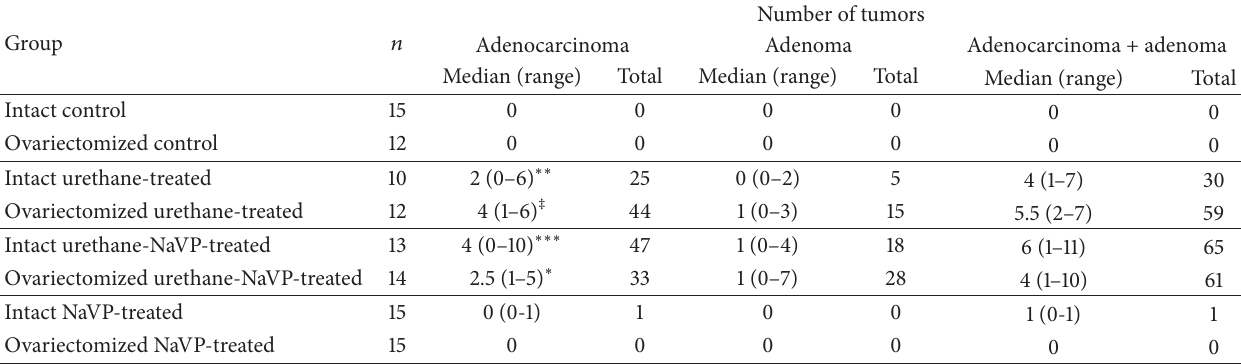
Table 3: Number of adenomas and adenocarcinomas in experimental mice